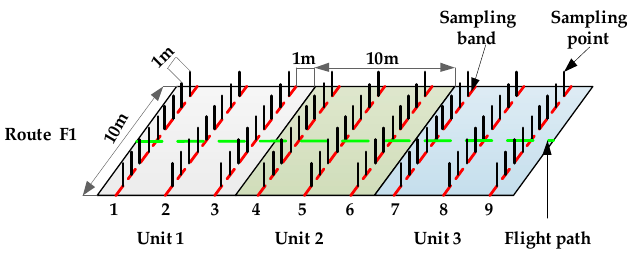
Figure 14. The diagram of the sampling bands.